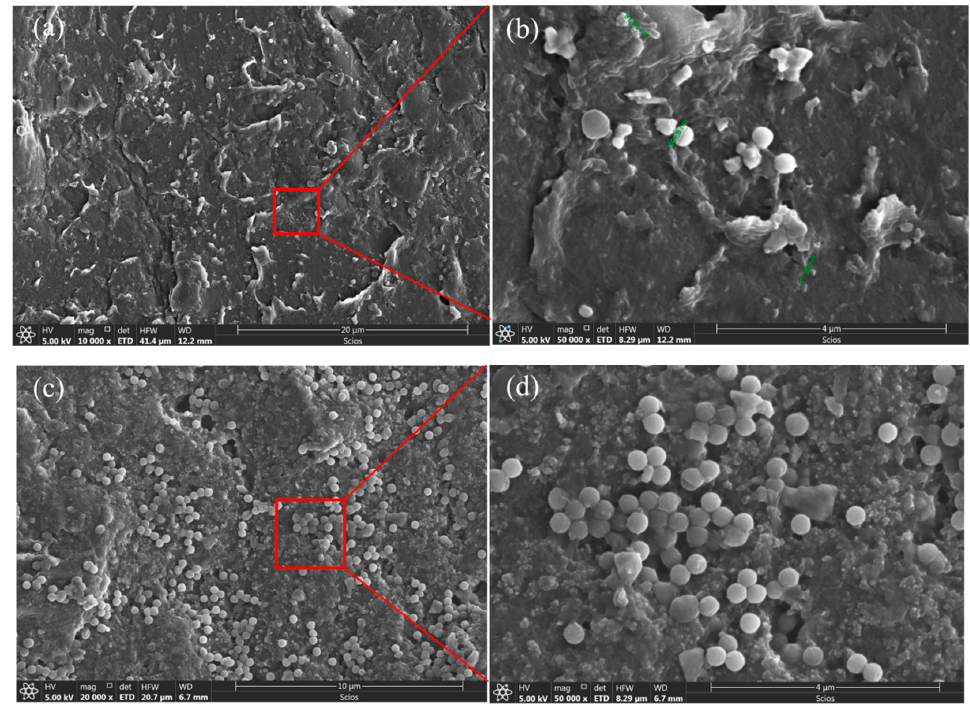
Figure 8. SEM surface micrographs: ( a ) 2 wt.% CB / 2 wt.% SiO 2 / PVDF film 10,000 × ; ( b ) 2 wt.% CB / 2 wt.% SiO 2 / PVDF film 50,000 × ; ( c ) 2 wt.% CB / 4 wt.% SiO 2 / PVDF film 20,000 × ; ( d ) 2 wt.% CB / 4 wt.% SiO 2 / PVDF film 50,000 × .